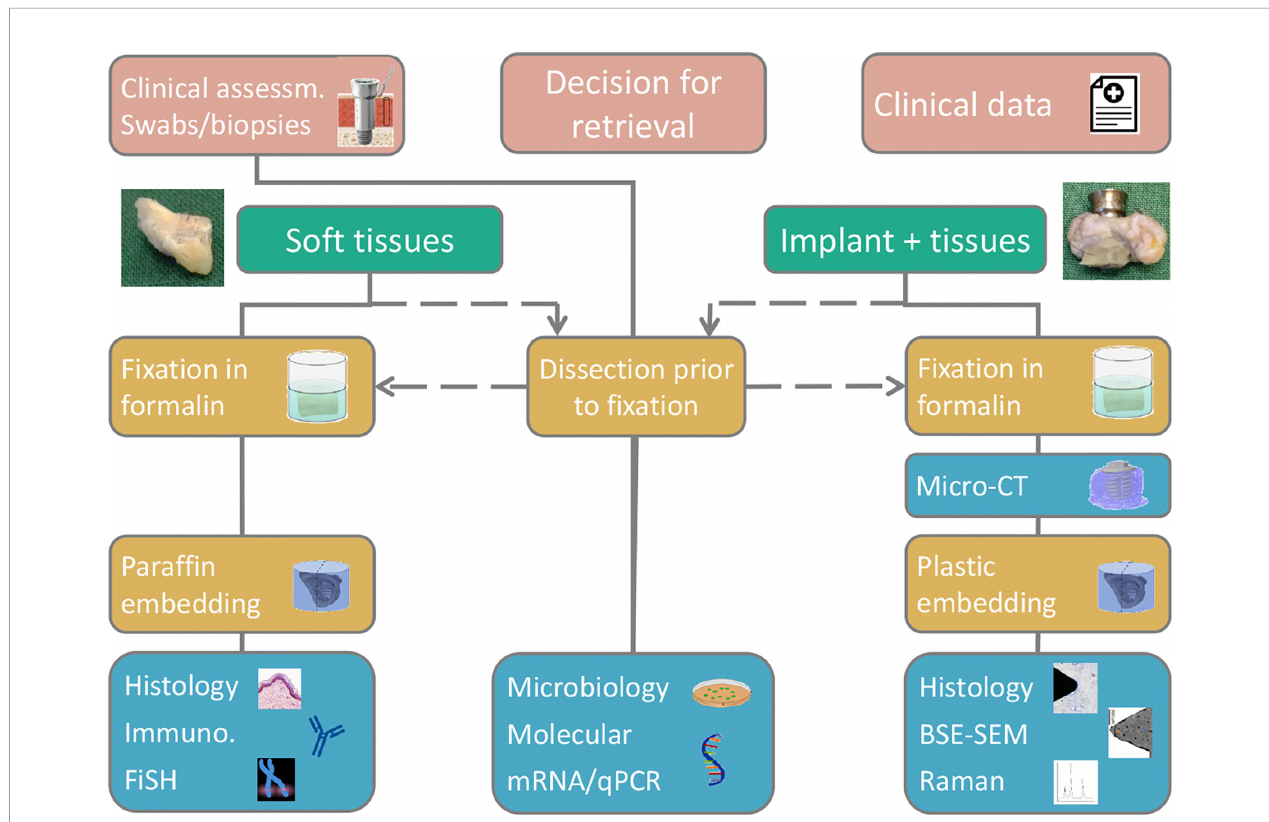
FIGURE 8 | A suggested fl ow chart for retrieval analyses, enabling a multimodal and multiscale approach, adapted for the Implant Retrieval Network. Depending on sample type retrieved (soft tissue, hard tissue, implant, abutment) various analytical methods are available, however, via different sample preservation and preparation